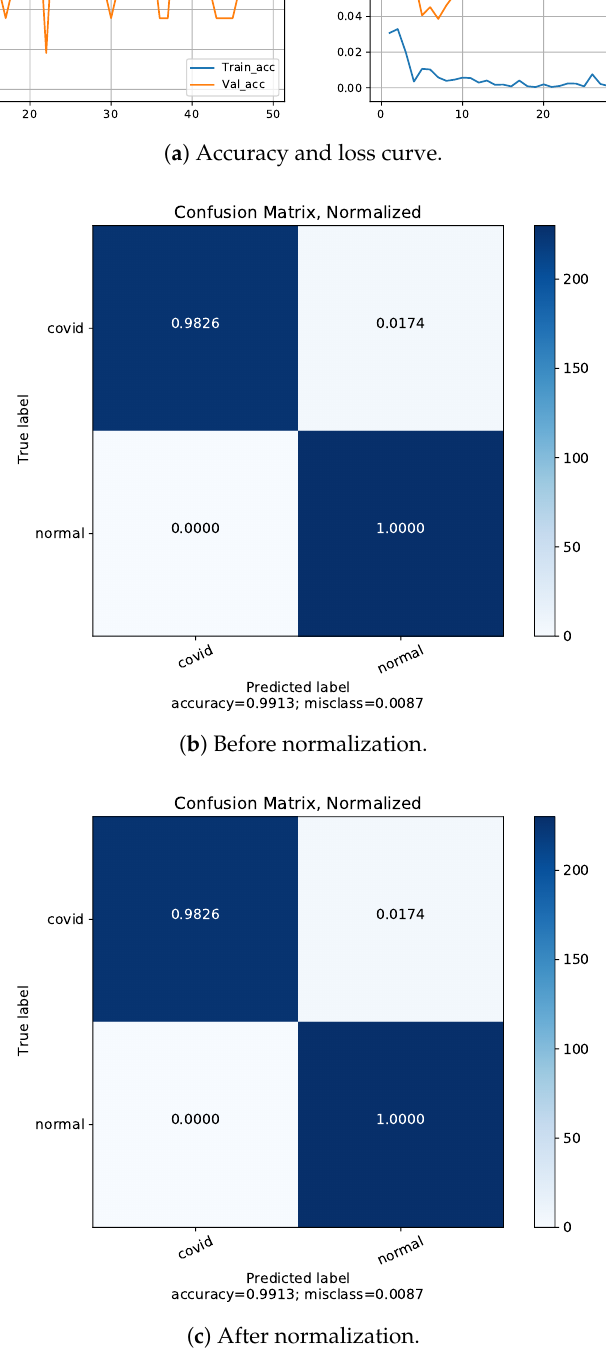
Figure 7. Results of Dataset-1 for 2-class: